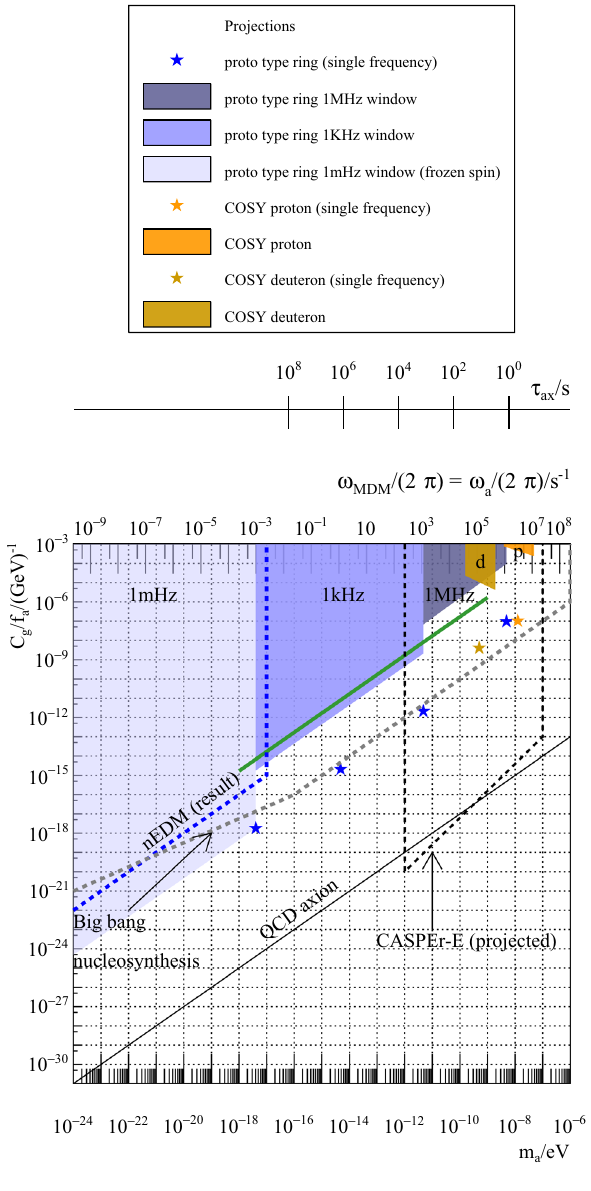
Fig. 4 One σ limits for the axion-gluon coupling C g / f a reachable within 1year running at a fixed frequency (stars) or over a given fre- quency range (areas) for COSY (orange) or the prototype ring (blue). In addition,limitsreachedbythenEDMexperiments[15],nucleosynthesis [16] and prospects for NMR experiments [5] are shown schematically. The green line shows the estimates obtained in [1] with